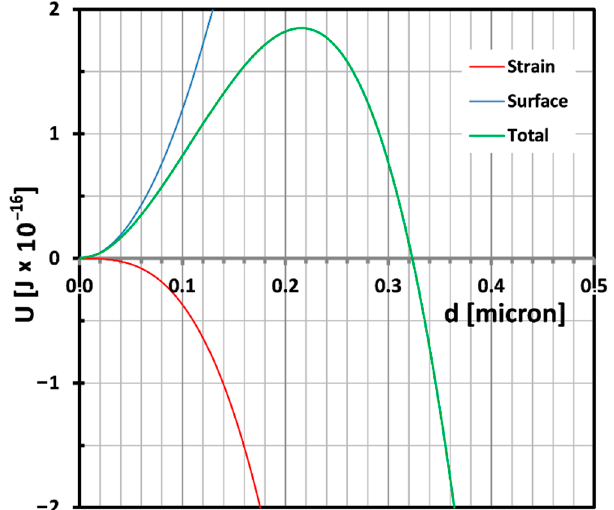
Figure 6. The balance of strain and surface energy in a rubber particle as a function of particle diameter for K r = 2.5 GPa and G = 0.4 MPa. The volume strain is the critical value proposed by Dijkstra et al. i.e., 0.75% [32]. The critical particle diameter in this case is then 330 nm.